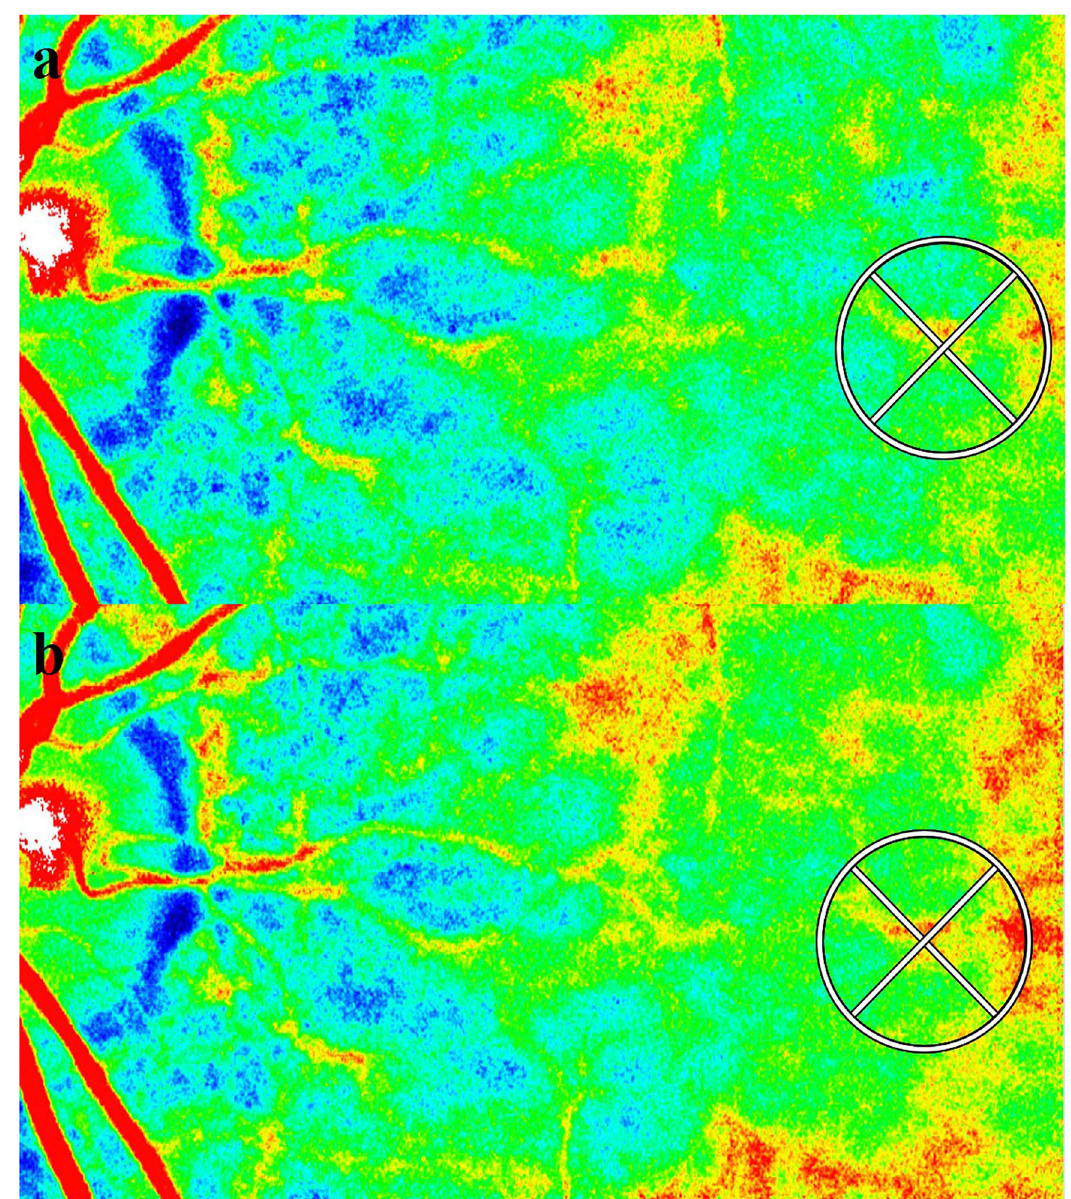
Fig 1. Composite color map images of the mean blur rate (MBR) measured using laser speckle flowgraphy in a representative participant (case 8). Blue coloring indicates low MBR, while red coloring indicates high MBR. MBR within the circle in the mid- luteal phase (b) increased by 19.8% compared to that in the late follicular phase (a).